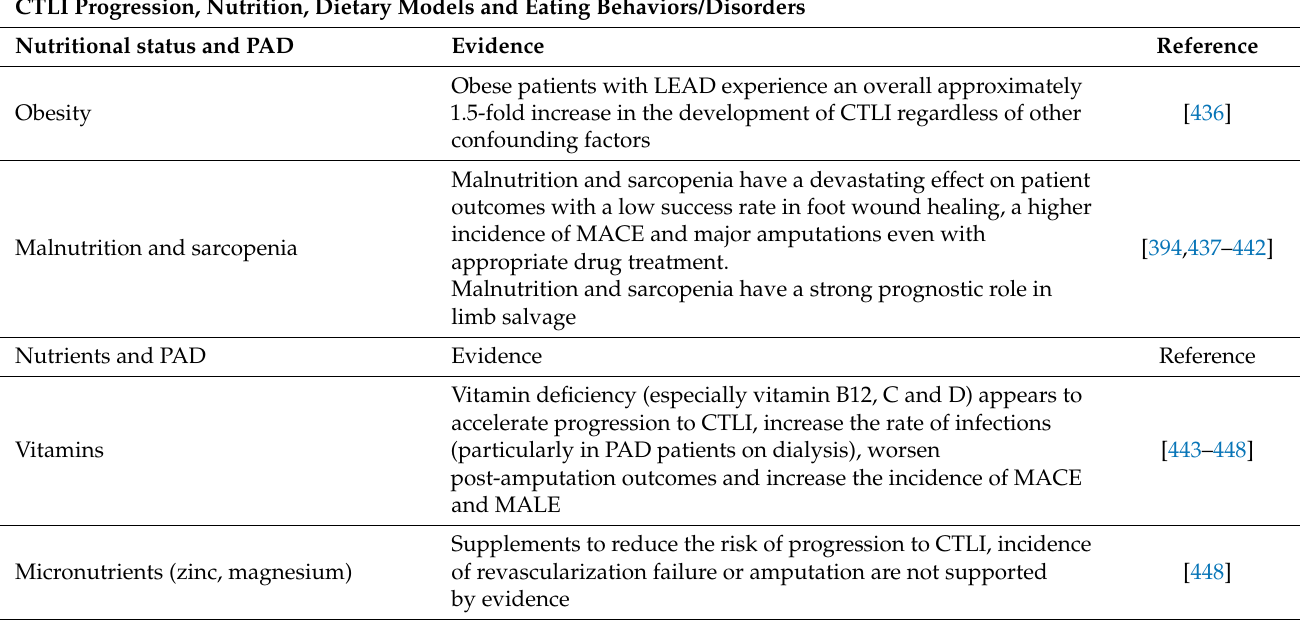
Table 4. CTLI progression, nutrition, dietary models and eating